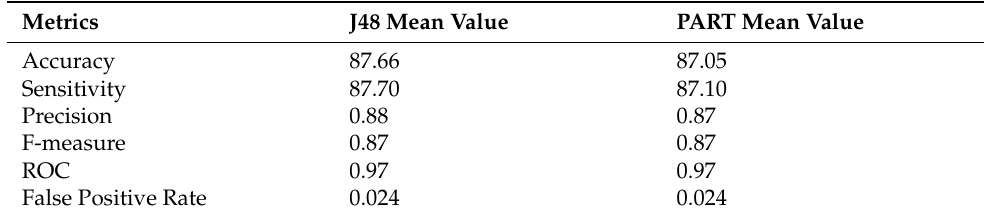
Table 5. J48 and PART algorithms multiclass classification results.